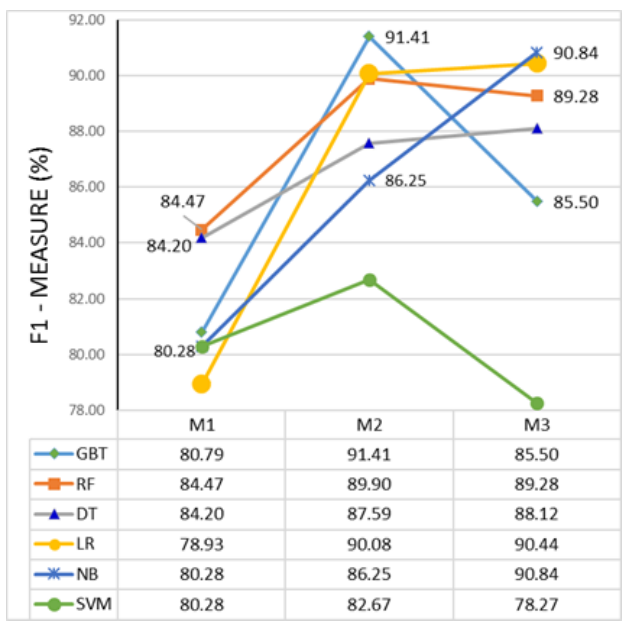
Figure 3. Performance of the F1 metric of each algorithm at each point in time M1, M2, M3.